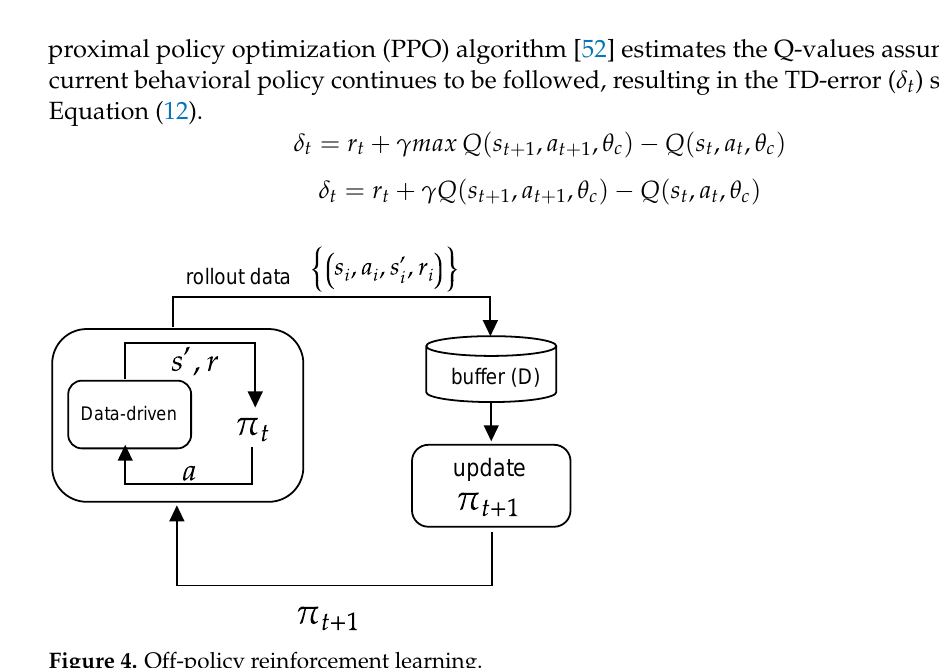
Figure 4. Off-policy reinforcement learning.